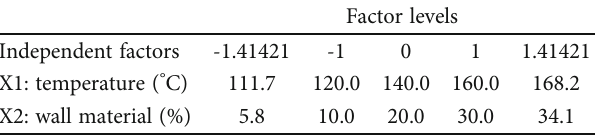
Table 1: Central composite design used to optimize the microencapsulation process of oregano ( Lippia graveolens ) phenolics.